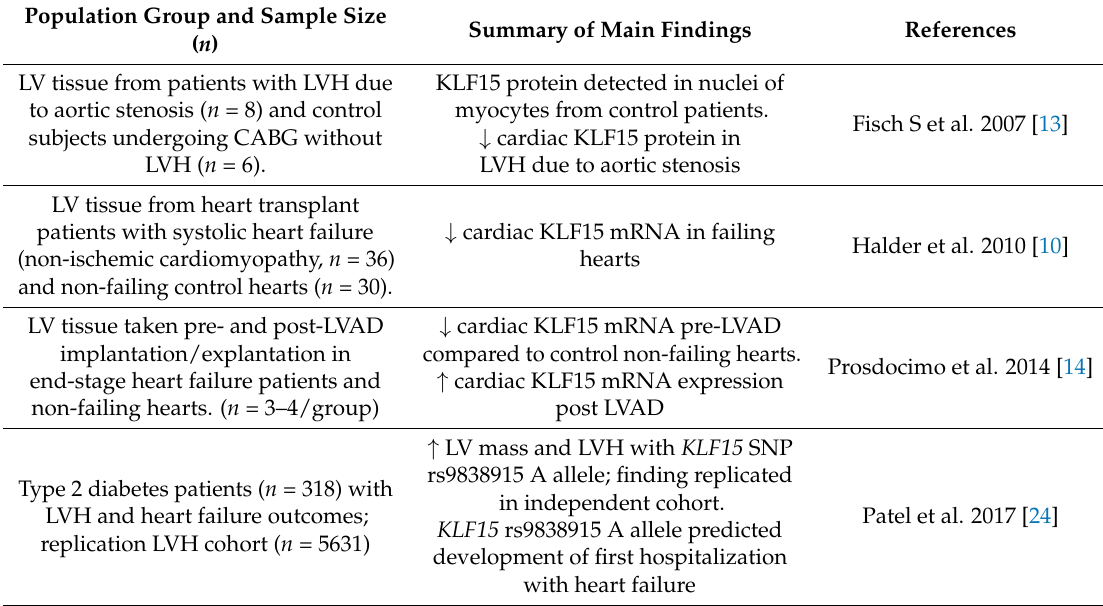
Table 3. Human studies of